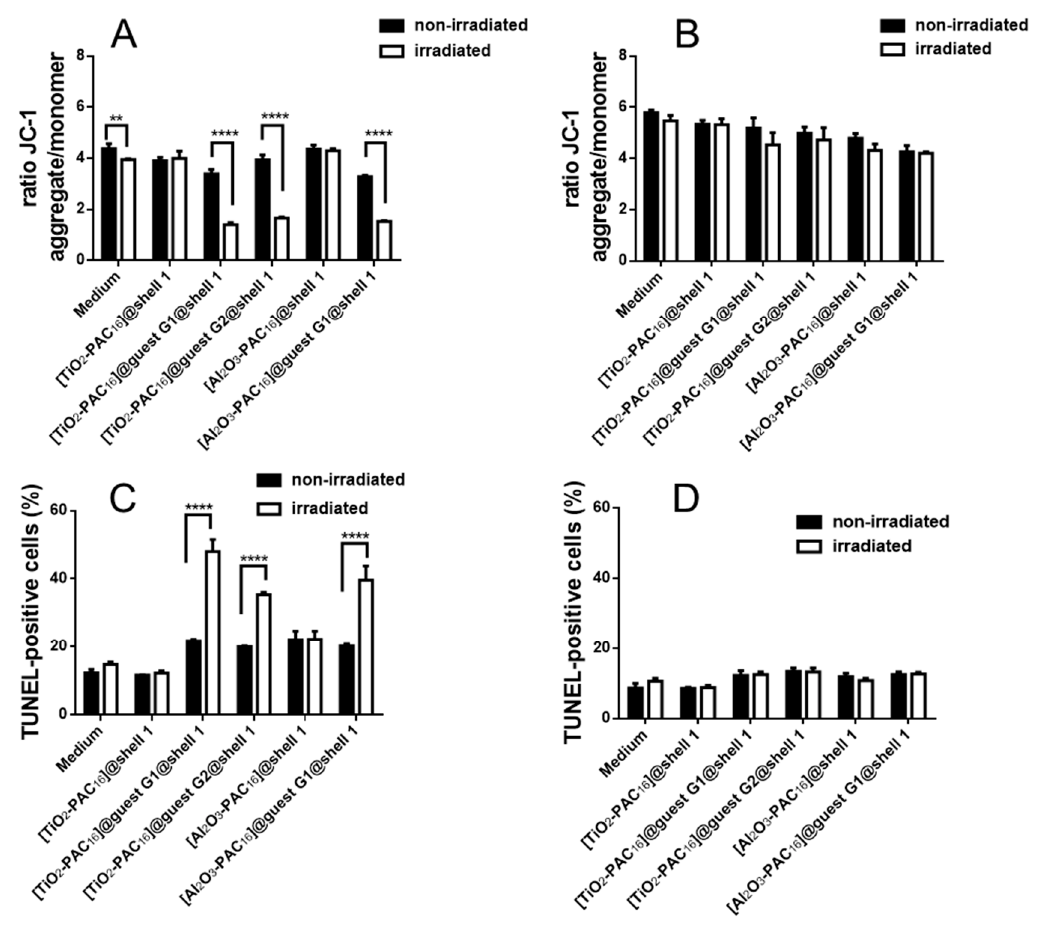
Figure 8. Changes of the mitochondrial membrane potential in MCF-7 ( A ) and MCF-10 A ( B ) cells expressed as ratio of fluorescence JC-1 aggregates (red) to monomers (green) and increase of DNA strand breaks in MCF-7 ( C ) and MCF-10 A ( D ) cells labeled by the TUNEL-assay, n = 6, **: p < 0.01, ****: p < 0.0001.